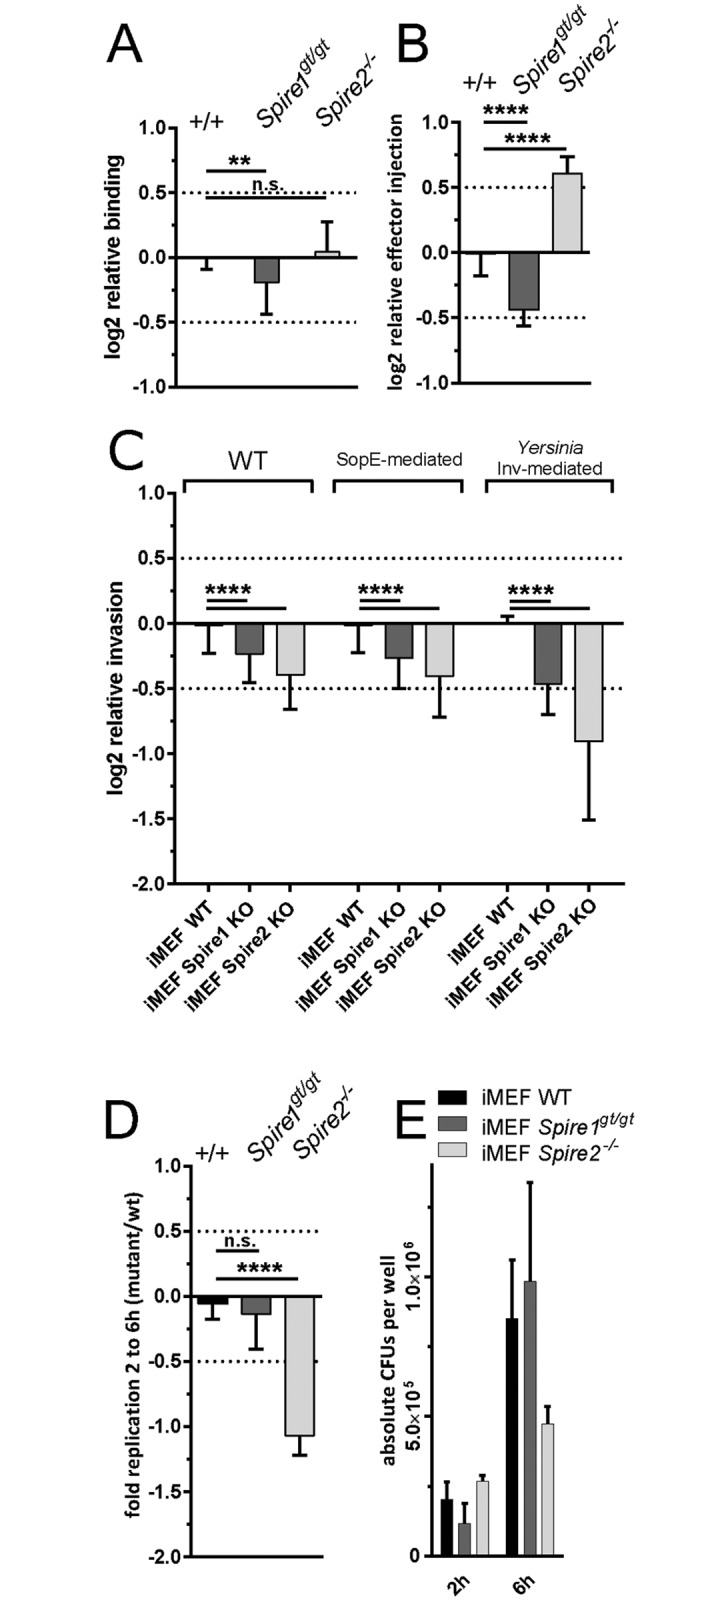
Infection step assays using iMEF cell lines.(A) Binding assay using Spire1gt/gt and Spire2-/- iMEFs normalized to the data from the wild type iMEF control cell line. Spire1gt/gt show reduced Salmonella binding. (B) Effector injection assay using Spire1gt/gt and Spire2-/- iMEFs normalized to the wild type iMEF control cell line. Spire1gt/gt and Spire2-/- cells show attenuation and increase in effector injection, respectively. (C) Modified gentamicin protection assay using Spire1gt/gt and Spire2-/- iMEFs normalized to the wild type iMEF control cell line. Spire1gt/gt and Spire2-/- cell lines show decrease in invasion after 4h. Invasion is not dependent on Salmonella effectors or invasion type. (D) Intracellular replication in Spire1gt/gt and Spire2-/- iMEFs normalized to the wild type iMEF control cell line measure by plating assay. Spire2-/- cell line shows decrease of intracellular bacterial replication. (E) Absolute number of CFUs corresponding to D. A-C show data from 3 independent experiments with 2 replicates each in HeLa Kyoto cells. D and E show data from 2 independent experiments with 3 replicates each. Asteriscs indicate significant differences. *: p<0.05.